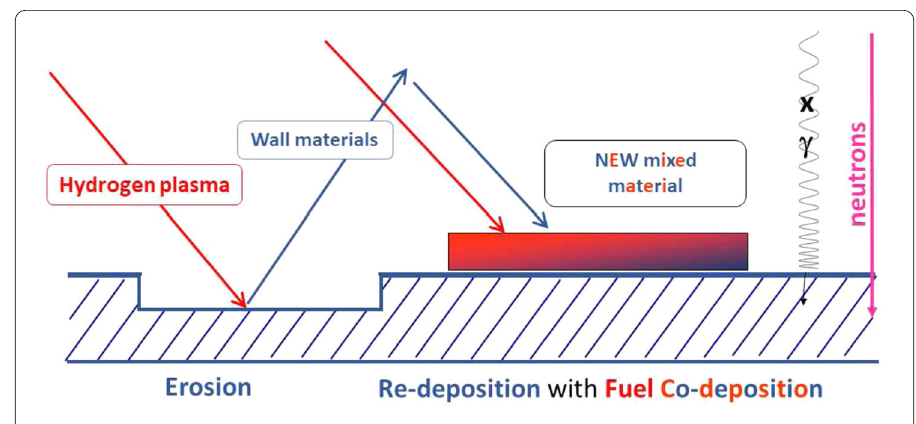
Figure 1 Plasma-wall interactions: schematic illustration of erosion-deposition processes